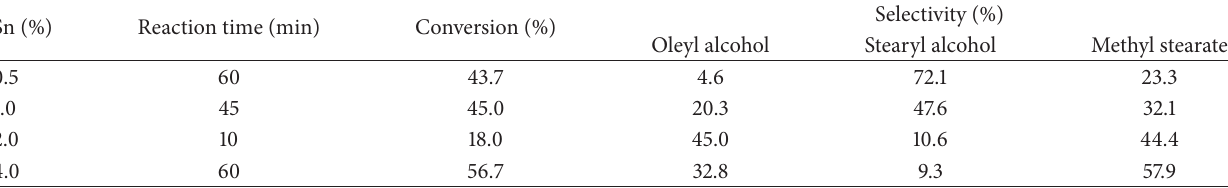
Table 3: Selectivity to different products at the point of maximum selectivity to oleyl alcohol. Ru(1%)-Sn( X %)-B/Al 2 O 3 catalysts. Sn (%) Reaction time (min) Conversion (%)